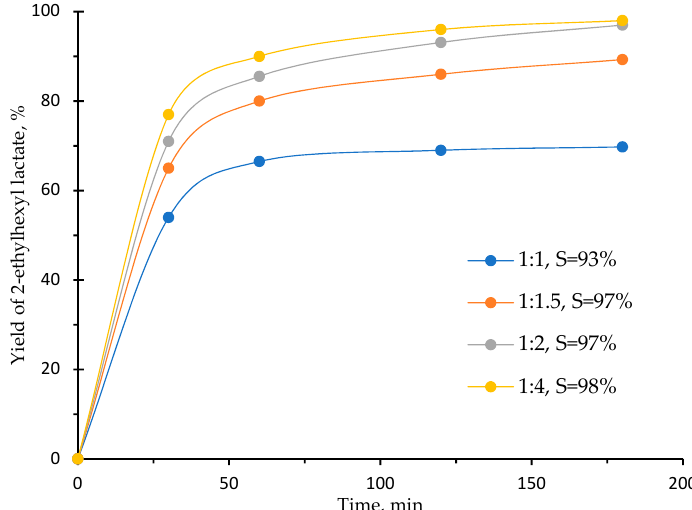
Figure 2. The influence of the ratio of the reactants on the yield of 2-ethylhexyl lactate.